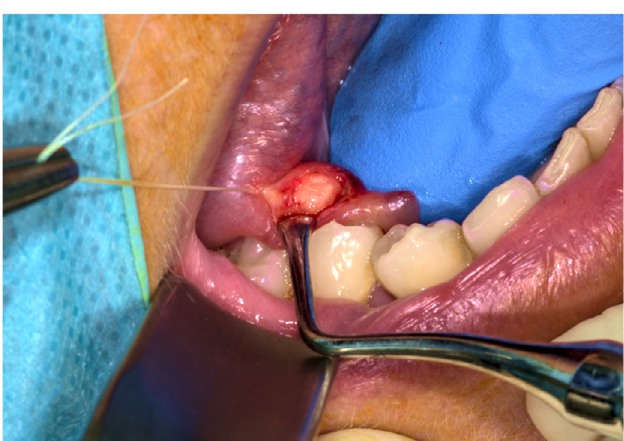
Fig. 14. Clinical view of a traction wire placed behind a